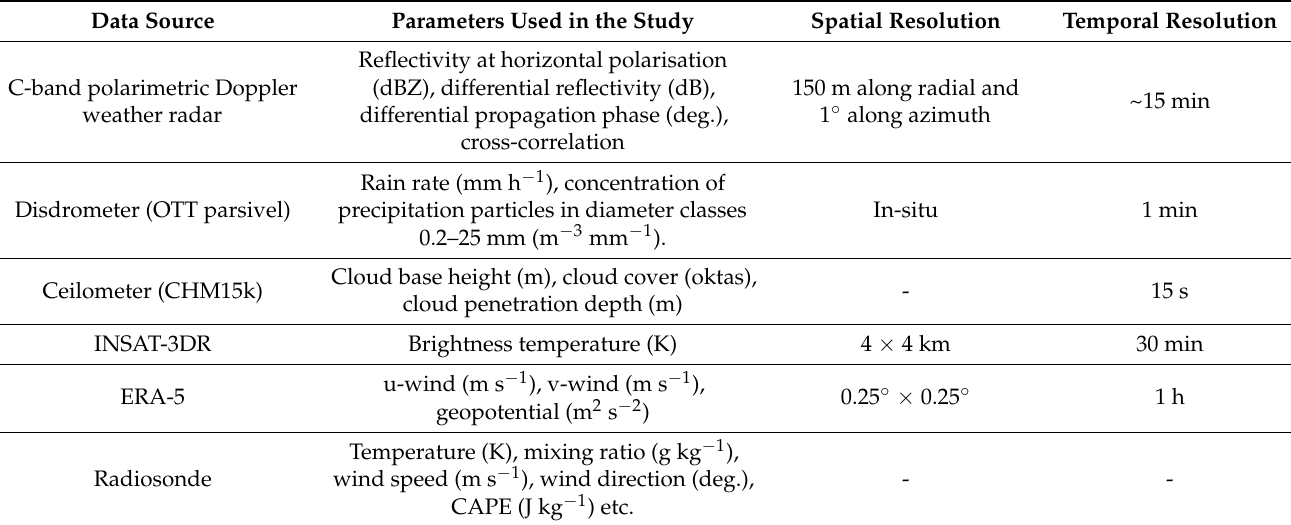
Table 1. Overview of the instruments and the data used in this